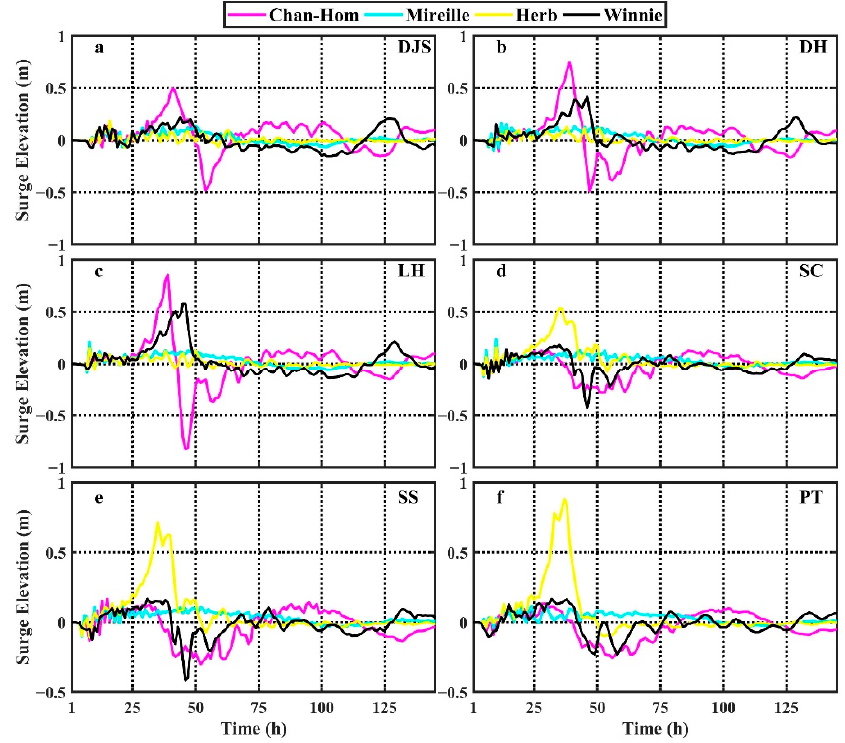
Figure 11. Time series of surge elevations in experiments with different path at six stations: ( a ) DJS, ( b ) DH, ( c ) LH, ( d ) SC, ( e ) SS, and ( f ) PT.